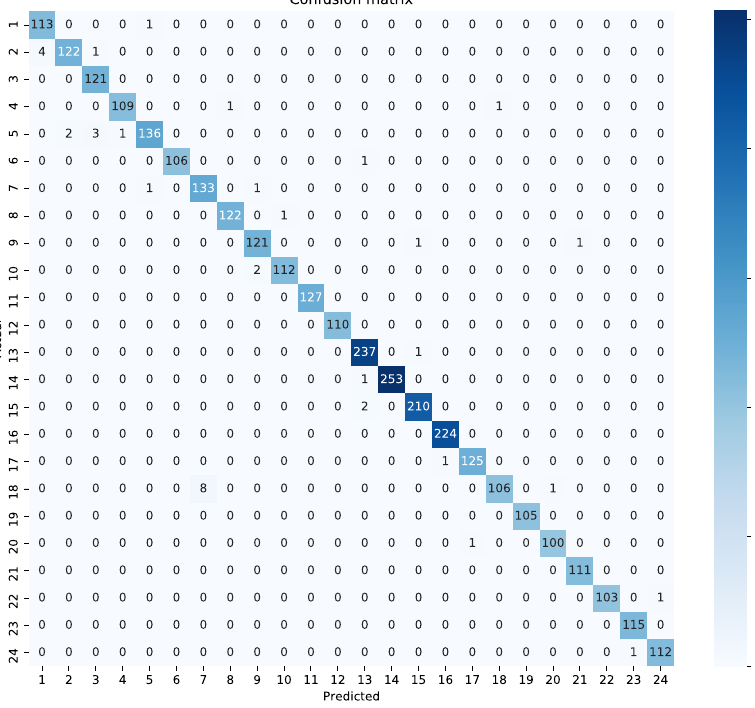
Figure 20. Confusion matrix for LoRa data for 0.01 learning rate and 100